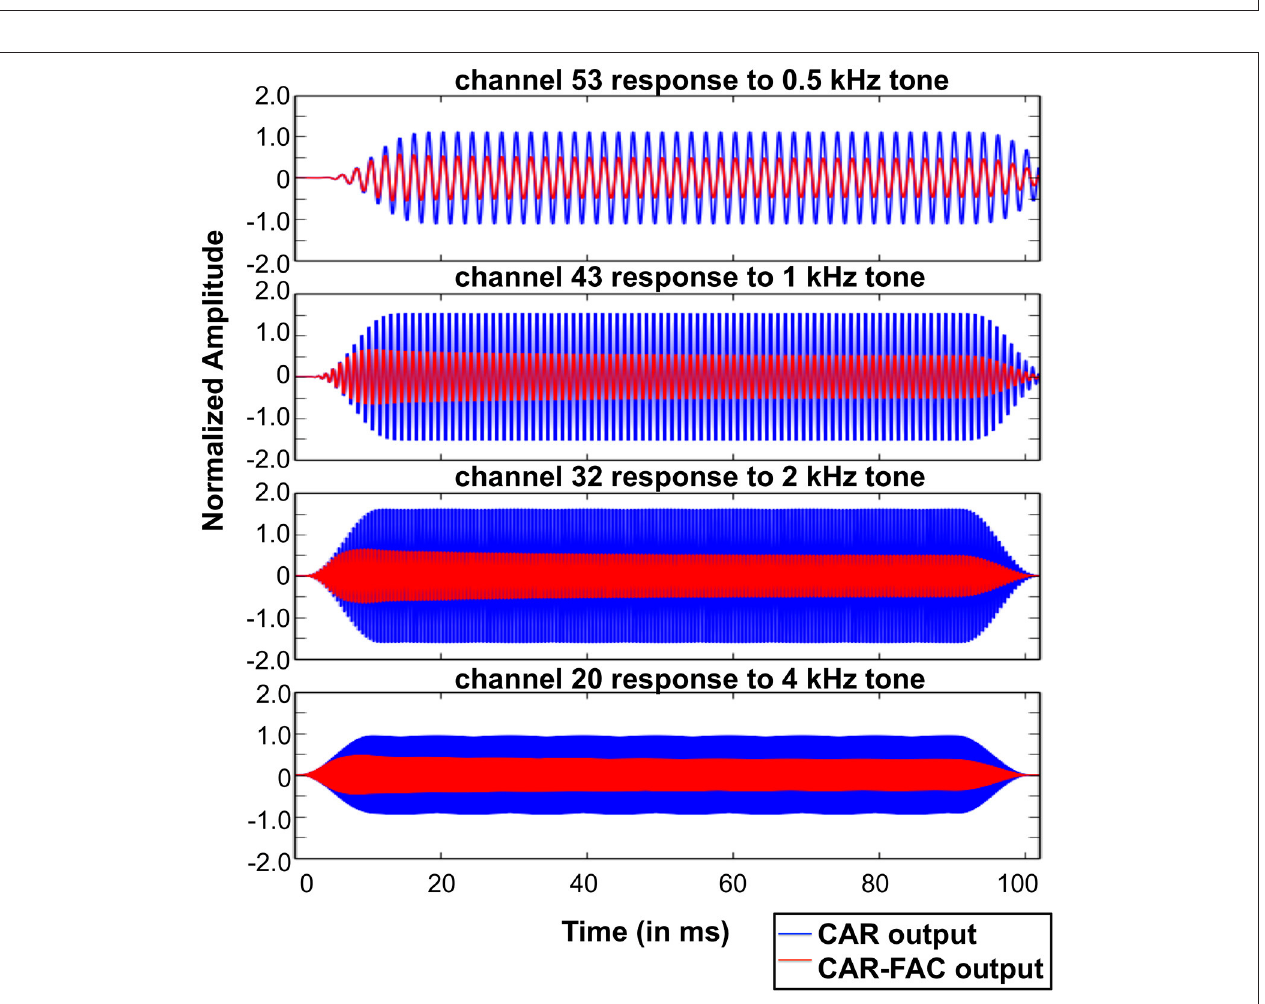
FIGURE 10 | CAR and CAR-FAC output in response to 0.5, 1, 2, and 4kHz tones with an amplitude of -40 dB FS at the channels of CFs corresponding to the input frequencies.